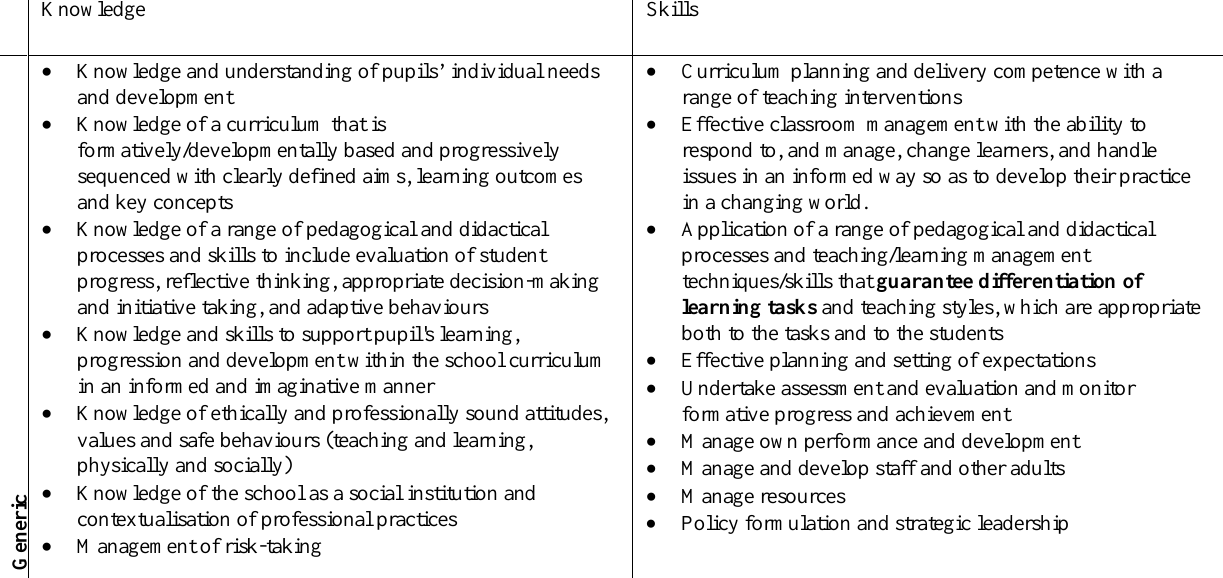
Table 1 Generic and specific knowledge and skills needed by physical educators in Europe